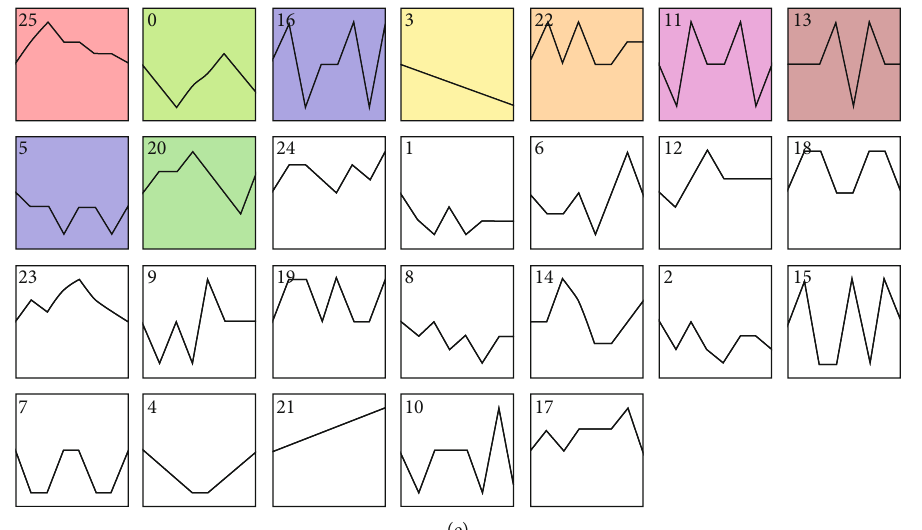
Figure 4: Trend analysis of gene expression (10 trends) and corresponding KEGG classi fi cation of gene. KEGG classi fi cation of cluster 9 (a) and KEGG classi fi cation of cluster 16 (b) and trend analysis of gene expression in XL106 (c). KEGG classi fi cation of cluster 0 (d). Trend analysis of gene expression in XL210 (e). Colored block trend: signi fi cant enrichment trend. Without color trend: the enrichment of signi fi cant